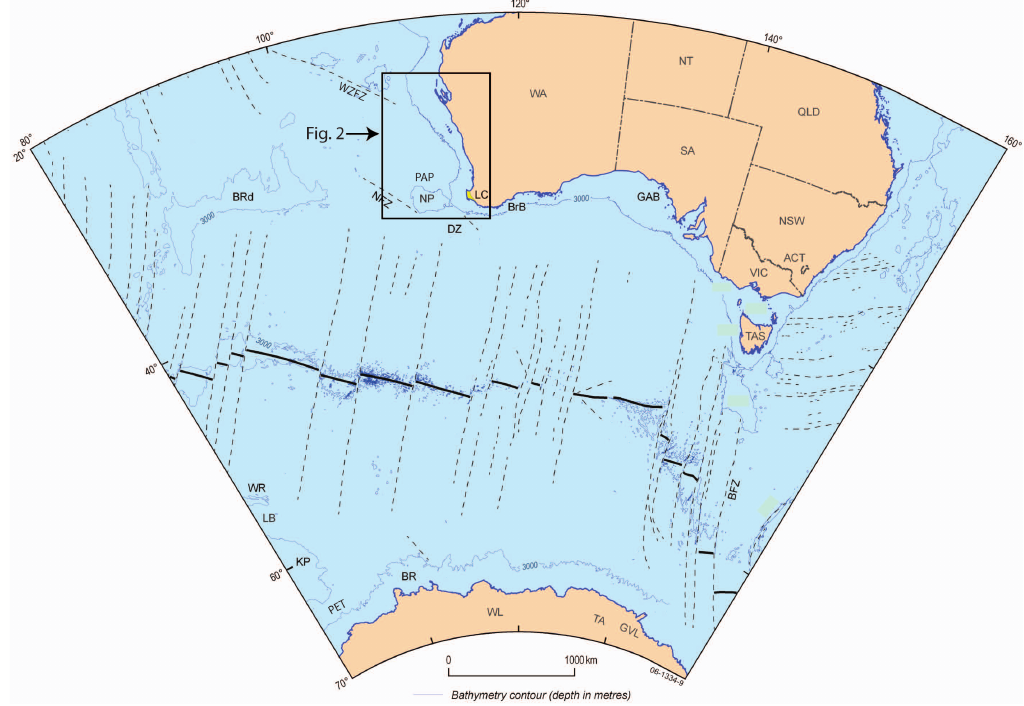
Fig. 1. Regional structural elements map of the Western Australian margin displaying the location of structural features that have led to the development of the Mentelle Basin. BRd = Broken Ridge; BR = Bruce Rise; DZ = Diamantina Zone; N = Naturaliste Plateau; NFZ = Naturaliste Fracture Zone ; LC = Leeuwin Complex; BrB = Bremer Basin; GAB = Great Australian Bight; GC = Gawler Craton; BFZ = Balleny Fracture Zone; MR = Macquarie Ridge; WR = Williams Ridge; LB = Labuan Basin; KP = (southern) Kerguelen Plateau; WL = Wilkes Land; TA = Terre Ad´elie; GVL = George V Land. WA = Western Australia; NT = Northern Territory; SA = South Australia; QLD = Queensland; NSW = New South Wales; ACT = Australian Capital Territory; VIC = Victoria; TAS = Tasmania; PET = Princess Elizabeth Trough; WZFZ = Wallaby-Zenith Fracture Zone; PAP = Perth Abyssal Plain (modified from Direen et al.,